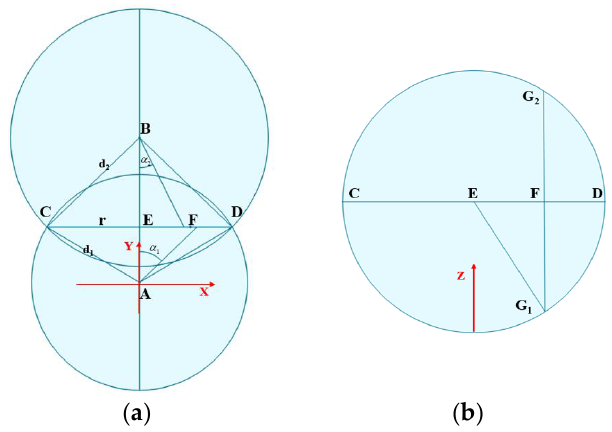
Figure 14. 3D localization principle analysis. ( a ) Top view; and, ( b ) Sectional view.